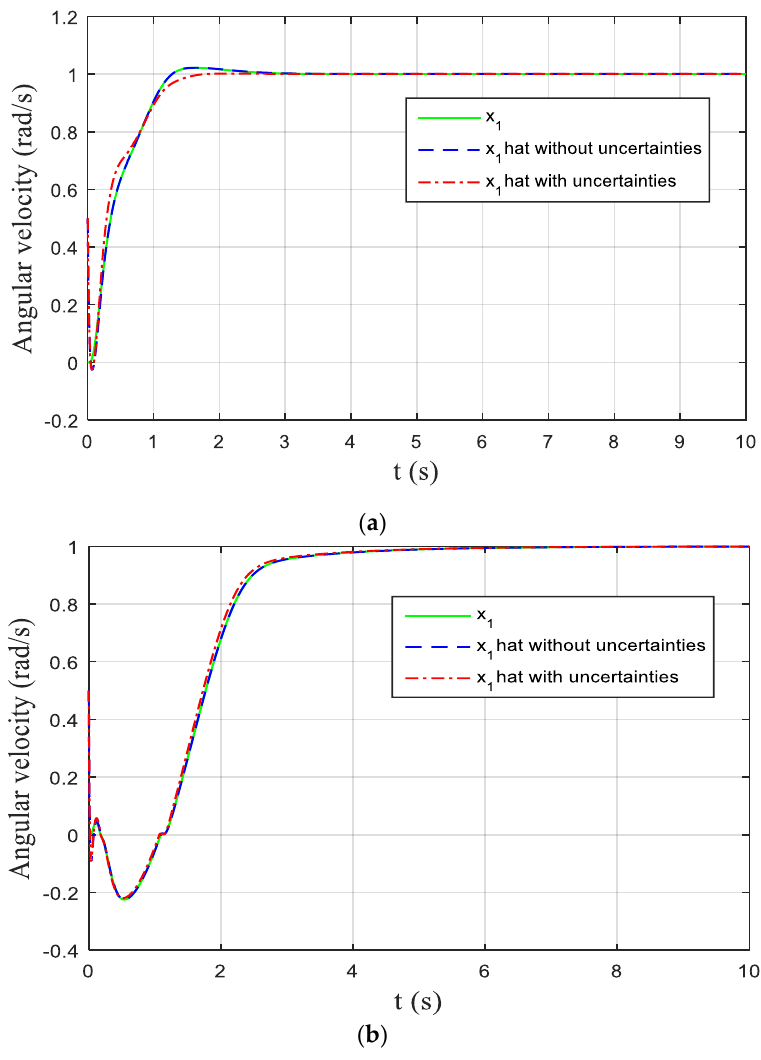
Figure 6. The angular velocity of PMDC motor of Equation (27) with parameter uncertainties.